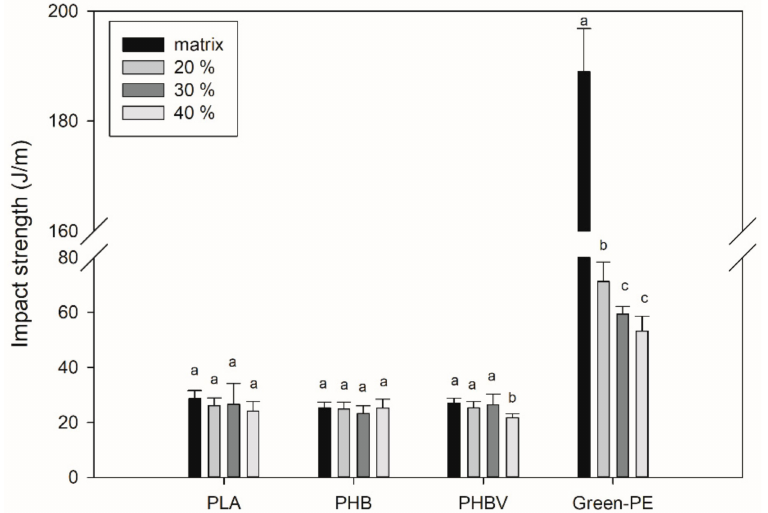
Figure 3. Impact strength of the biocomposites. Different letters (a–c) on the bars indicate significant differences ( p <